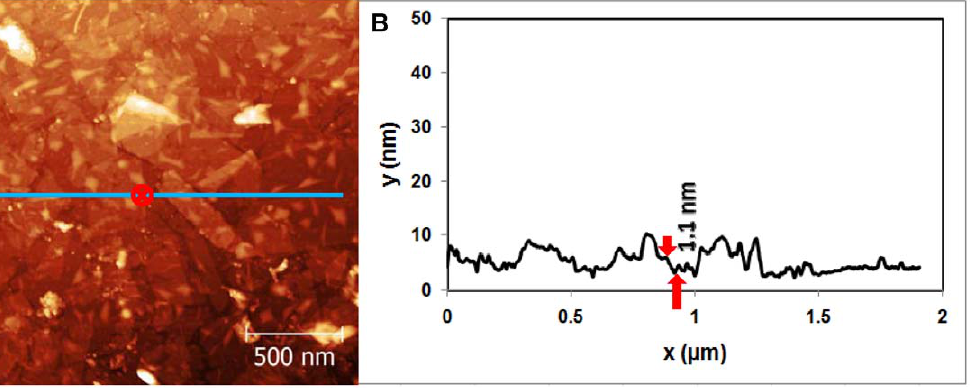
Figure 6. Topography of Mica/GaAl 12 /Nanosheets/APTES/Phage l /UV sample. (A) AFM image of virus solution adhered on SNT coated mica after the 15 min UV exposure. (B) Cross sectional image along the blue line shown in (A).